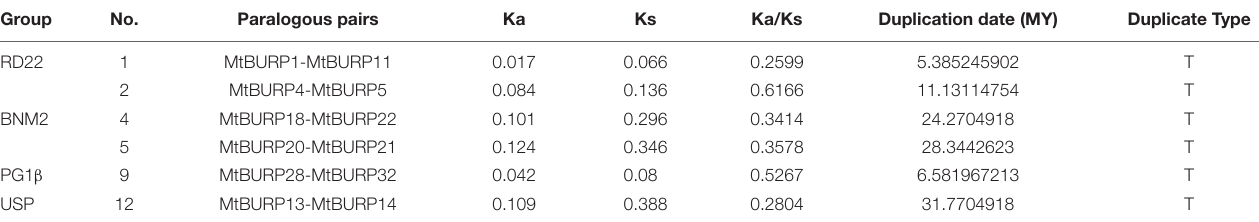
TABLE 2 | Divergence between paralogous BURP gene pairs in Medicago . Group No.